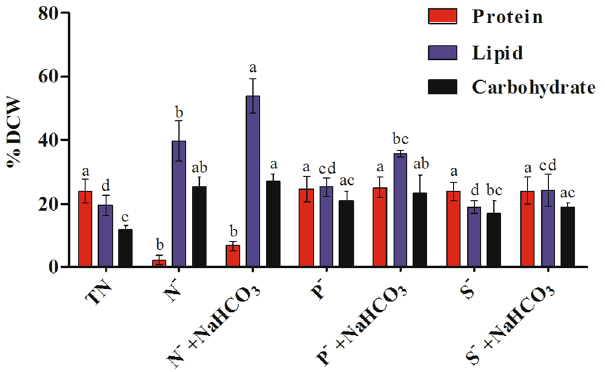
Figure 2. Effect of bicarbonate on protein, carbohydrate and lipid content of dry cell weight (DCW) of D. salina under nutrient deficit conditions. All values are expressed as Mean ± SD (n = 3). Values with different letters represent significantly differ at p < 0.05 between the groups. Total Nutrient (TN); Nitrate deficit (N − ); Nitrate deficit with bicarbonate (N − + NaHCO 3 ); Phosphate deficit (P − ); Phosphate deficit with bicarbonate (P − + NaHCO 3 ); Sulphate deficit (S − ); Sulphate deficit with bicarbonate (S − + NaHCO 3 ).